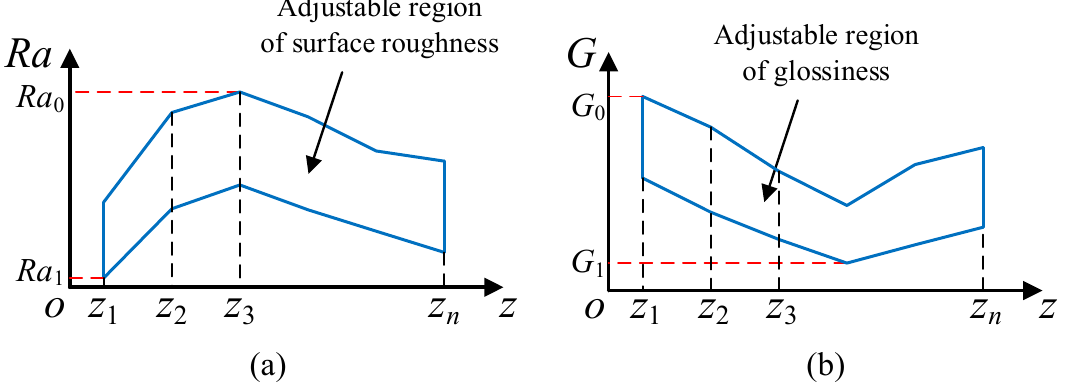
Figure 10. The adjustable region of ( a ) surface roughness and ( b ) glossiness.